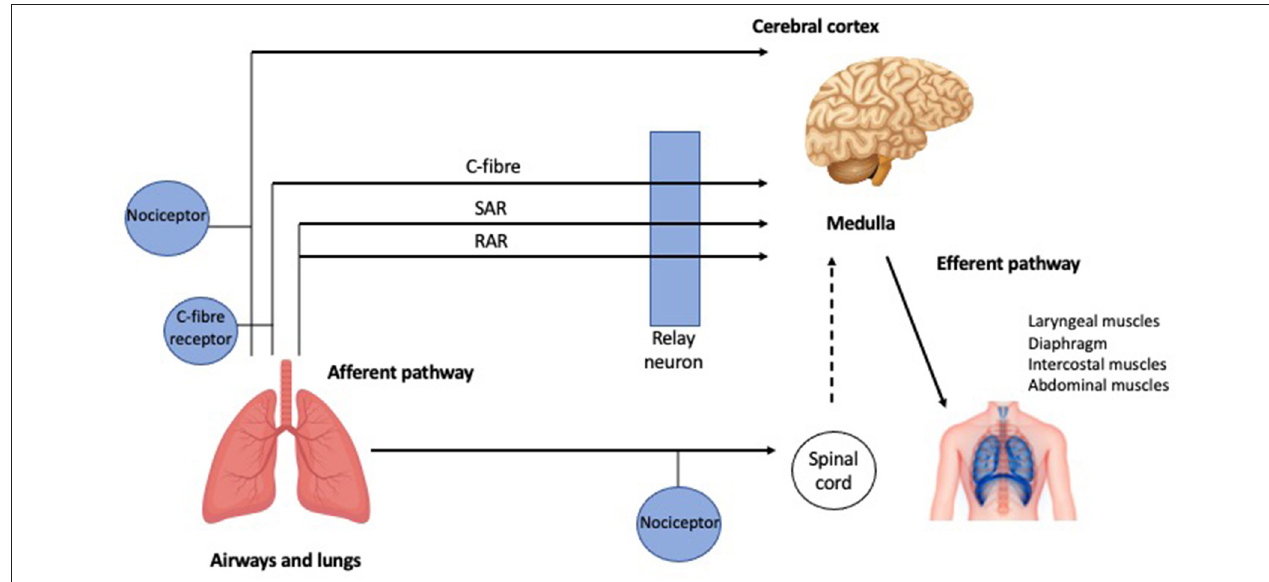
FIGURE 2 | The cough reflex. Schematic representation of the afferent and efferent pathways of the cough reflex (further detail in the text). RAR, Rapidly adapting receptors; SAR, slowly adapting stretch receptors [adapted from Mazzone (19) with permission from